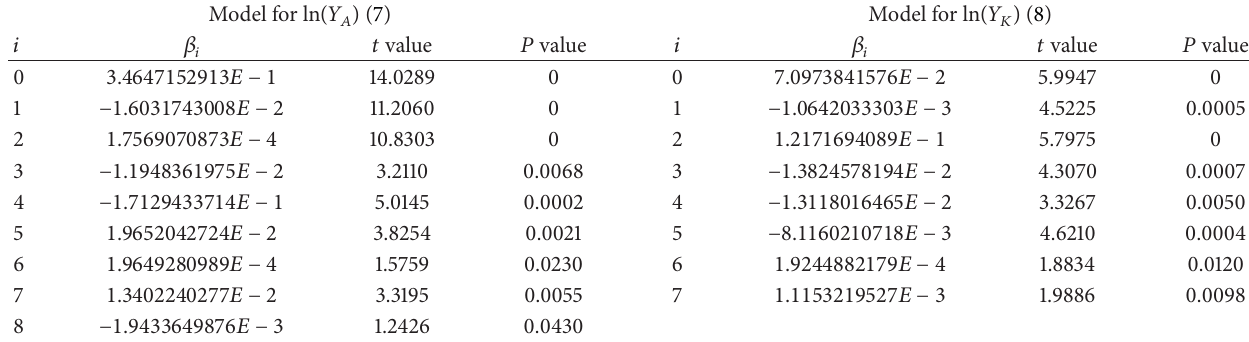
Table 3: Coefficients and their significance in the multivariate process models for the sludge yields during liquid-liquid extraction.